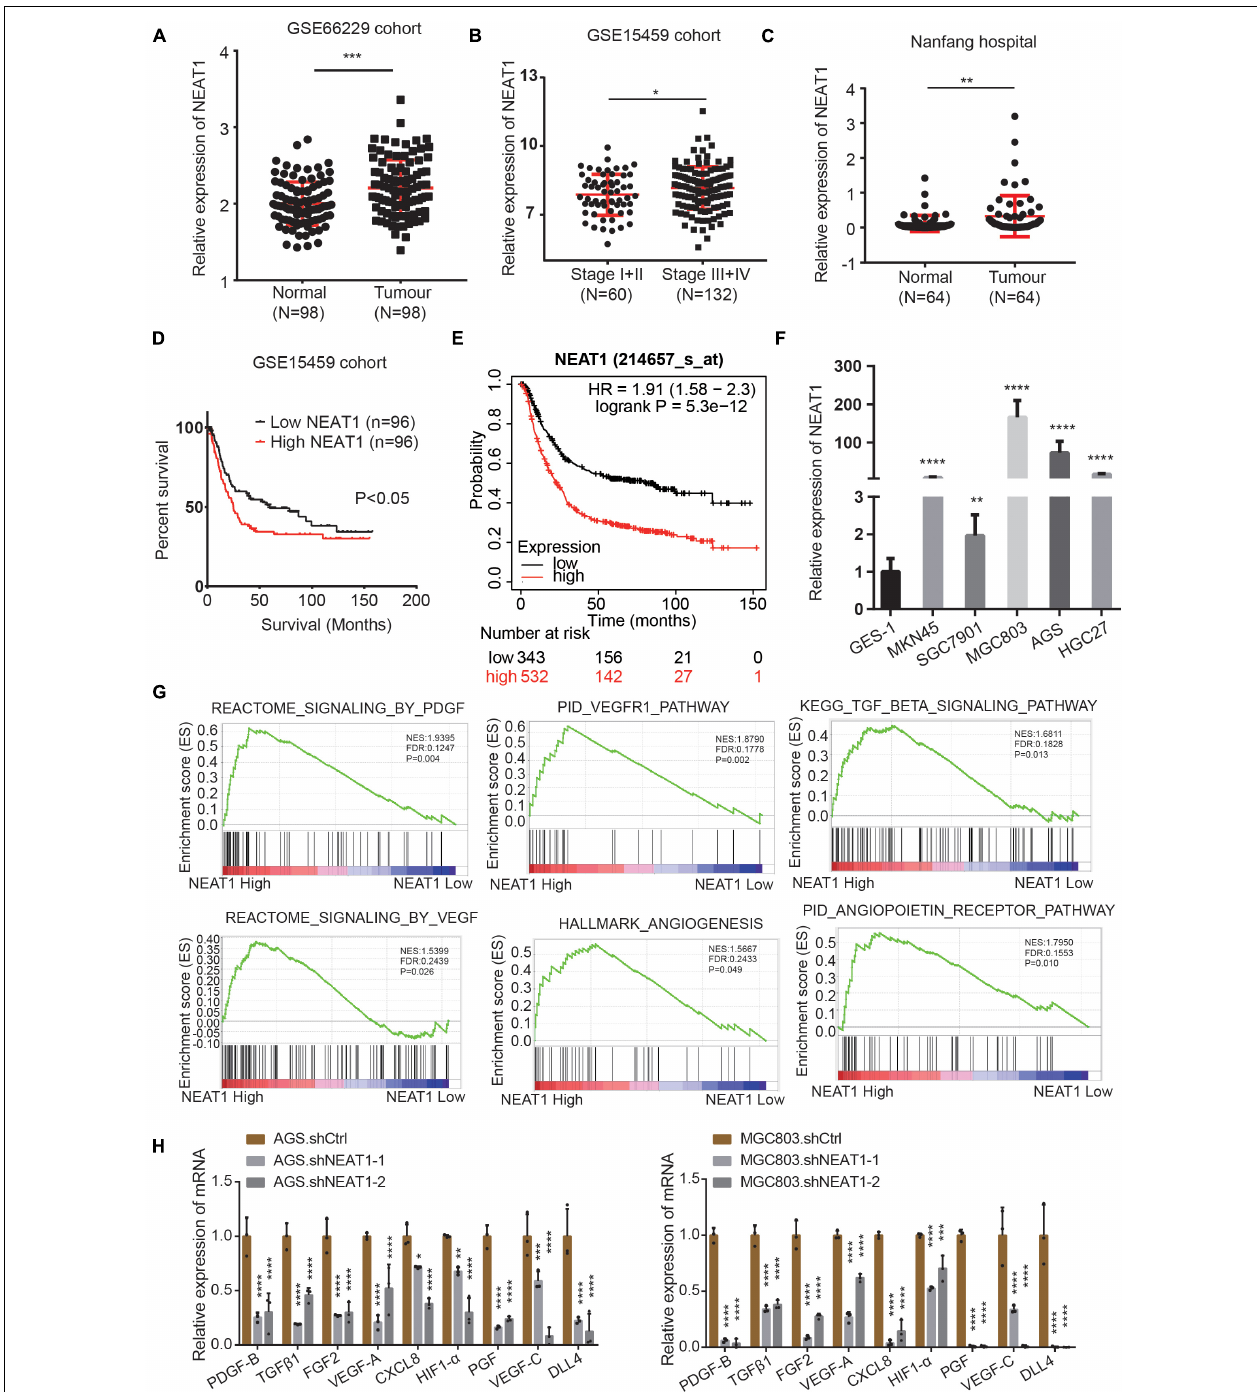
FIGURE 1 | LncRNA NEAT1 upregulation correlates with poor prognosis and angiogenesis in GC. (A) Scatter diagram represents the expression level of LncRNA NEAT1 in GC ( n = 98) and normal gastric tissues ( n = 98) derived from the GEO GSE66229 dataset. (B) NEAT1 expression level in GC tissues with TNM stage I + II ( n = 60) and stage III + IV ( n = 132). Data were derived from GSE15459 dataset. (C) Expression levels of NEAT1 were examined by RT-qPCR in 64 GC tissues and their pair-matched adjacent normal tissues from Nanfang hospital. (D) Kaplan-Meier analysis was used to assess the relation between NEAT1 expression level and overall survival in GC patients from GSE15459 cohort. (E) Kaplan-Meier plotter analysis of the correlation of NEAT1 expression level with overall survival of GC patients by the KM Plotter database. (F) The expression levels of NEAT1 in the GC cell lines and normal stomach mucosal cell line were determined by RT-qPCR. (G) GSEA validated angiogenesis-related pathways in high NEAT1 expression GC cohorts of GSE15459 dataset. (H) RT-qPCR detects the effects of silencing NEAT1 on the expression of classical proangiogenic factors in AGS and MGC803 cells (mean ± SD, n = 3). * P < 0.05, ** P < 0.01, *** P < 0.001, **** P < 0.0001.